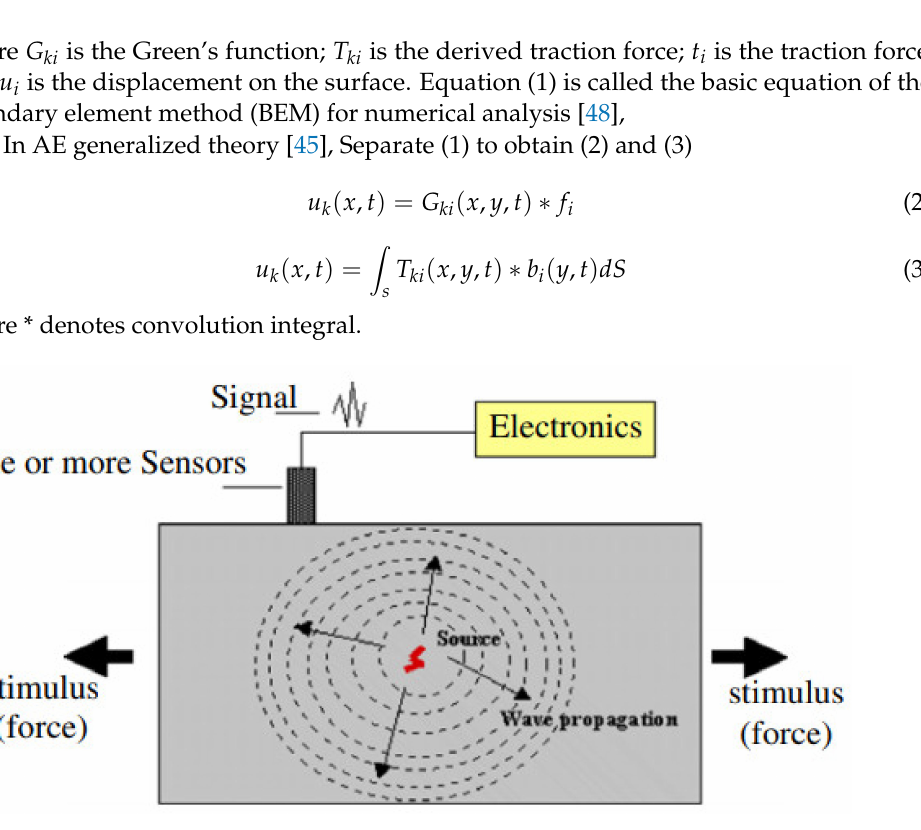
Figure 1. Principle of acoustic emission